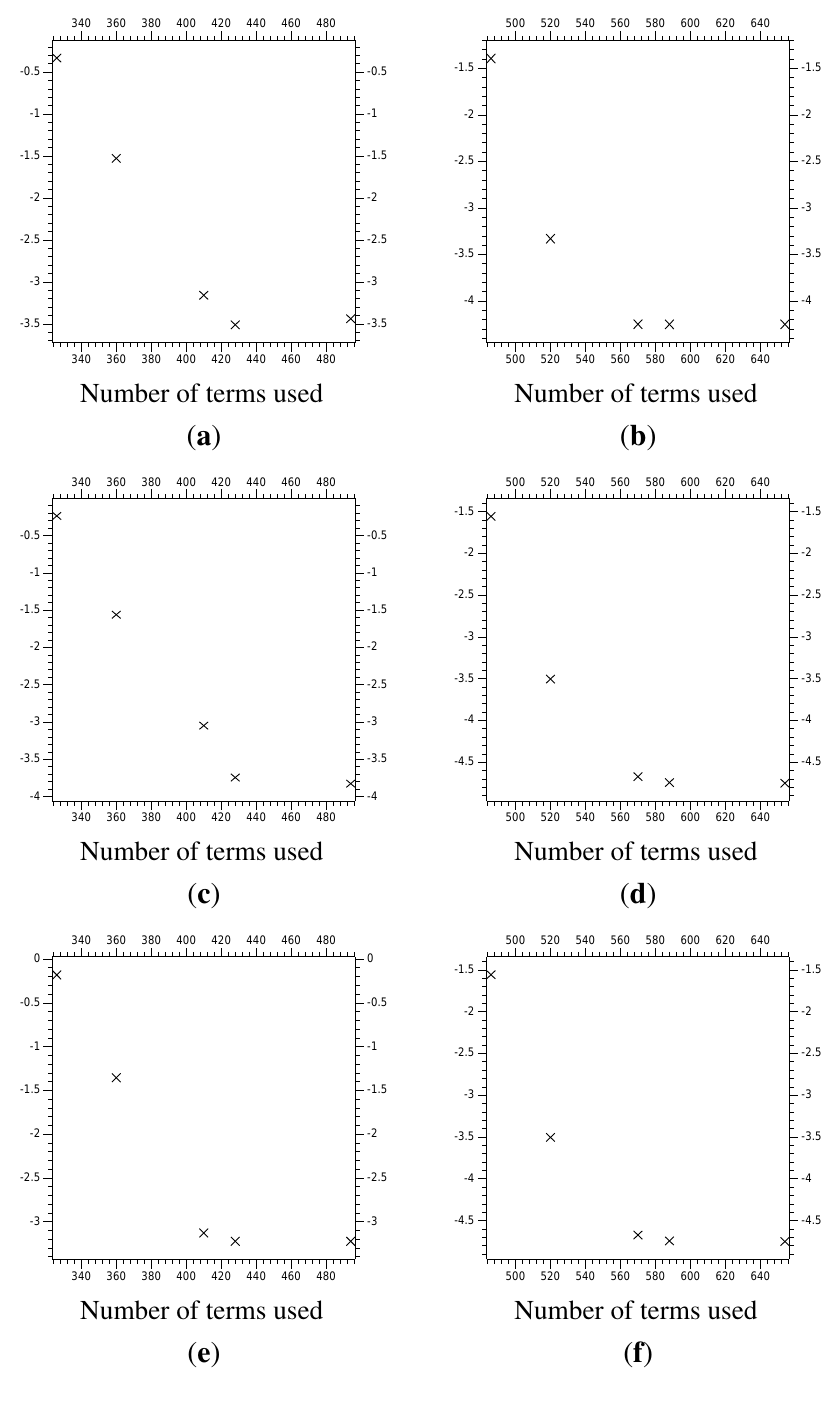
Figure 17. The error at t = 200 of the function Z from the linear problem. The vertical axis is the log of the error (the difference between the multi-scale system results and the 10 V − control results). The horizontal axis is the total number of a and b coefficients used 6 j;k j;k for the y directional decomposition. ( a ) log of the L 2 error for V − with V − on Λ ; ( b ) 4 6 10 log of the L 2 error for V − with V − on Λ ; ( c ) log of the L 1 error for V − with V − on Λ ; 5 6 4 6 10 10 ( d ) log of the L 1 error for V − with V − on Λ ; ( e ) log of the L ∞ error for V − with V − 5 6 4 6 10 10 on Λ ; ( f ) log of the L ∞ error for V − with V − on Λ 5 6 10